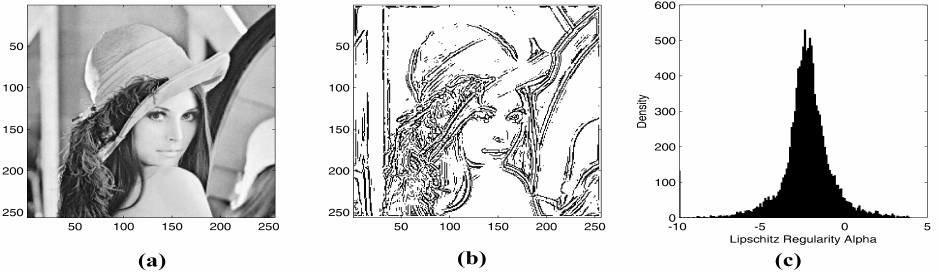
Figure 6. ( a ) Original Lena image, ( b ) modulus maxima after thresholding, ( c ) histogram of Lipschitz exponents correspond to maxima lines in ( b ).